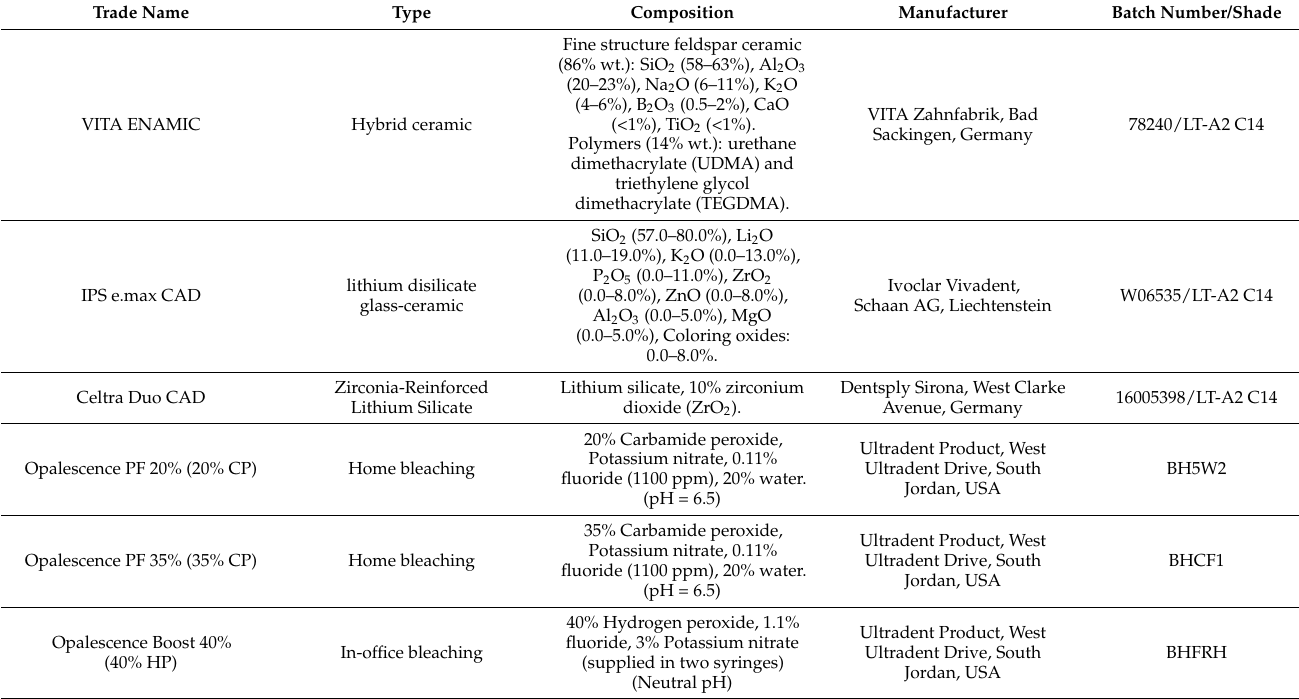
Table 1. The composition and manufacturer details of the tested ceramic materials.